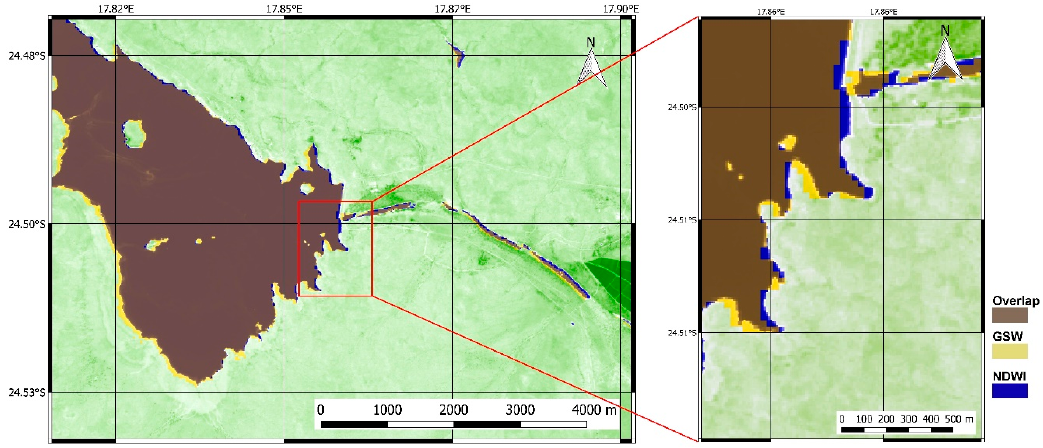
Figure 3. Comparison A: Hardap Dam GSW for September 2015 (orange) with Sentinel-2A Level 1C Normalized Difference Water Index (NDWI) (blue >0.5) from 22 September 2015 and overlap (grey).